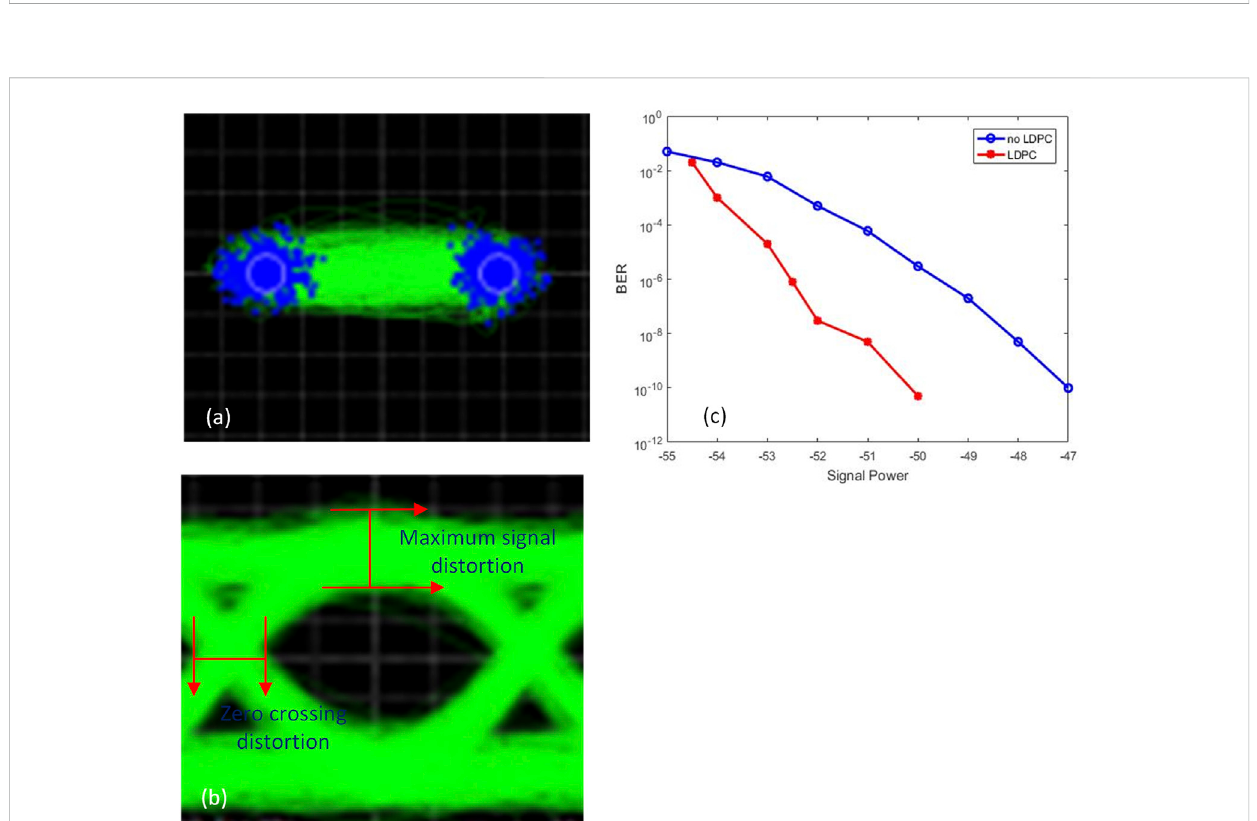
The eye map distribution after demodulation, which is a communication performance evaluation method, is illustrated in Figure 11B. In the fi gure, a thicker eyelid of eye diagram can be obviously found, which is due to the distortion of the maximum signal at the sampling time. Moreover, the over-zero point at the intersection of the two oblique lines can express the characteristics of